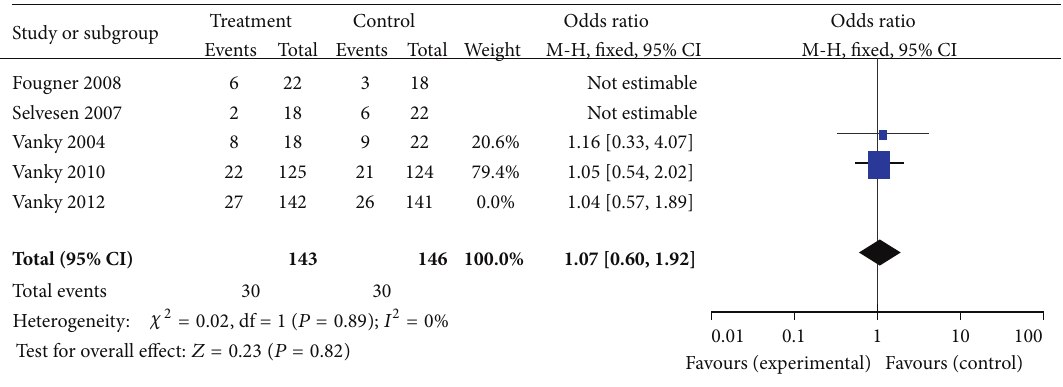
Figure 2: The meta-analysis of the odds ratio for gestational diabetes in